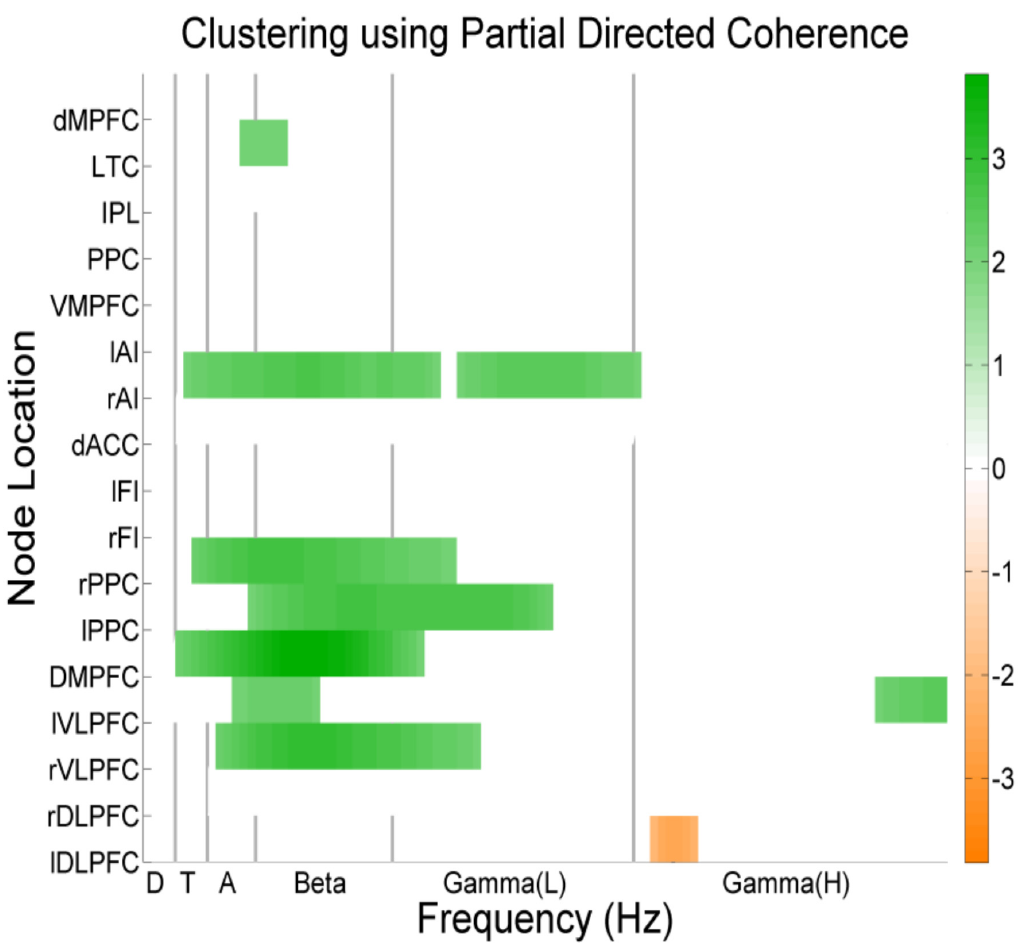
Fig 5. Non-aggregated nodal network connectivity. Clustering coefficient of PDC values in nodal analysis for beta band for patients (green) and controls (orange).